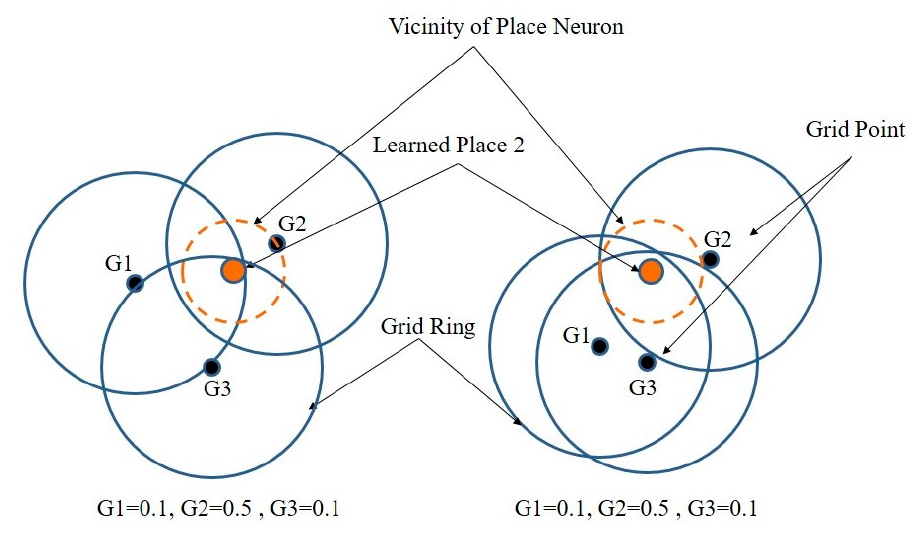
Figure 5. Ambiguity in grid code.